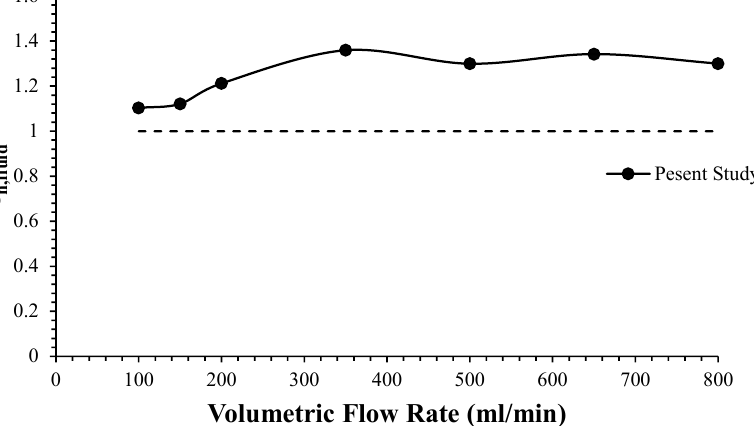
Figure 11. In empty channel, thermal performance of nanofluid according to volumetric flow.